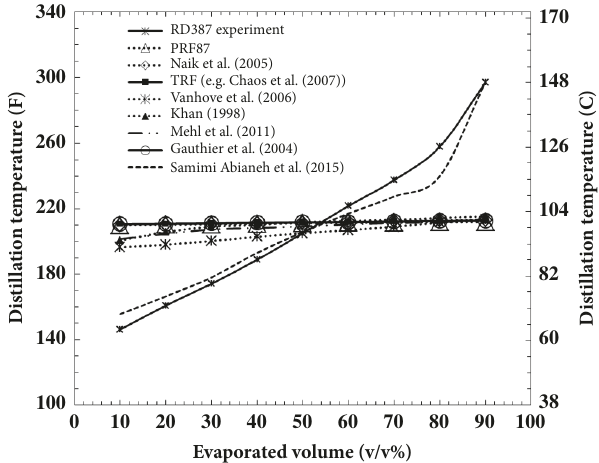
Figure 10: Distillation curves for gasoline RD387 fuel and sur- rogates. The simulated distillation curves are based on the staged equilibrium distillation model.